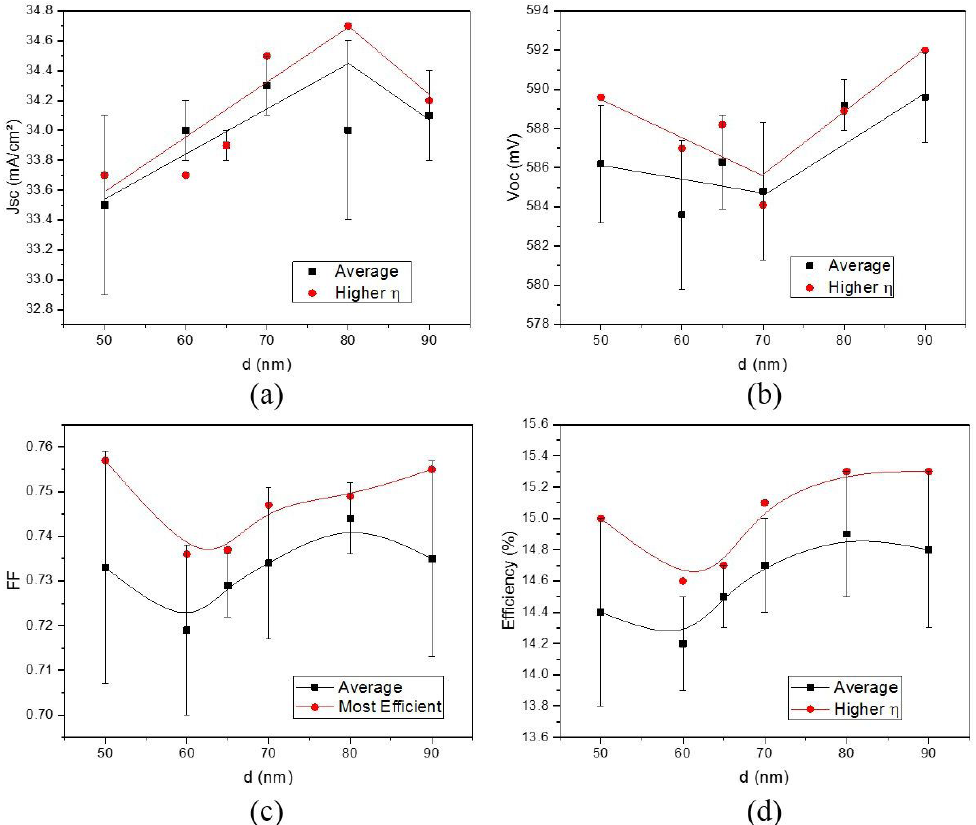
, (b) V , (c) FF and (d) efficiency of solar cells produced as a function of TiO Figure 6. (a) J SC OC